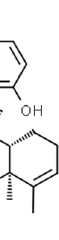
Figure 1. Chemical structure of avarol.